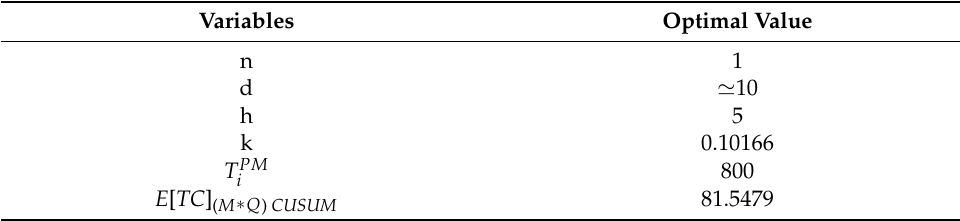
Table 3. An optimal set of decision variables for the proposed model.